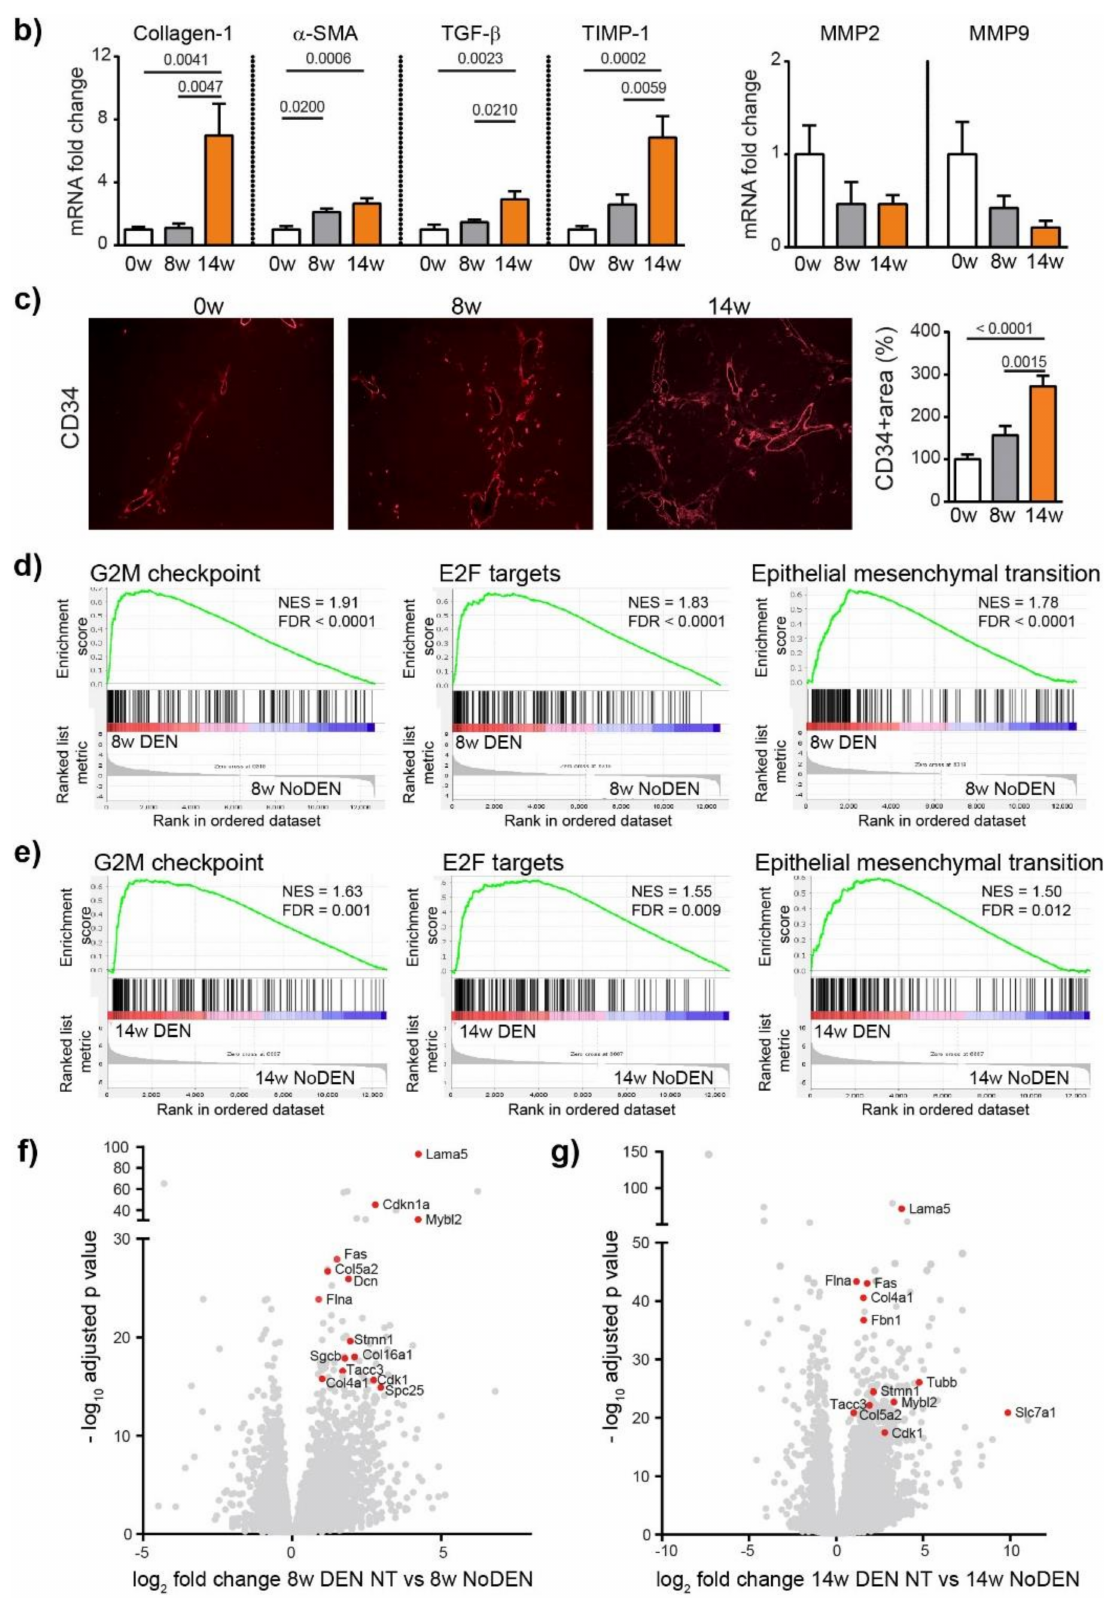
Figure 2. Chronic DEN induces fibrosis and abnormal vasculature. ( a ) Representative images of liver tissue stained with Sirius red (4 × magnification) and quantification of Sirius red-stained area per high power field (HPF) represented on bar graph; 0 w was set as 100%. Values are mean ± SE, n = 9/group. ( b ) qPCR analysis of collagen1, α -SMA, TGF- β ,